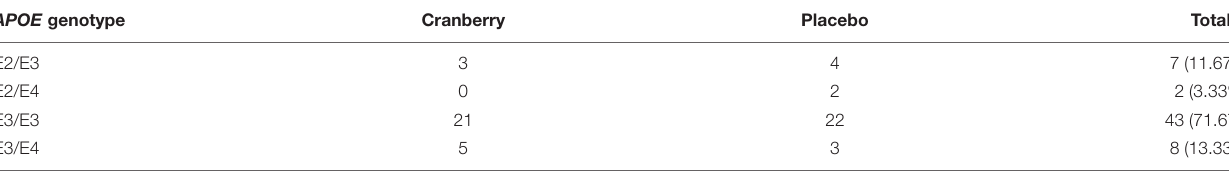
TABLE 6 | APOE genetic status of participants in the cranberry and placebo groups, and overall totals. APOE genotype Cranberry